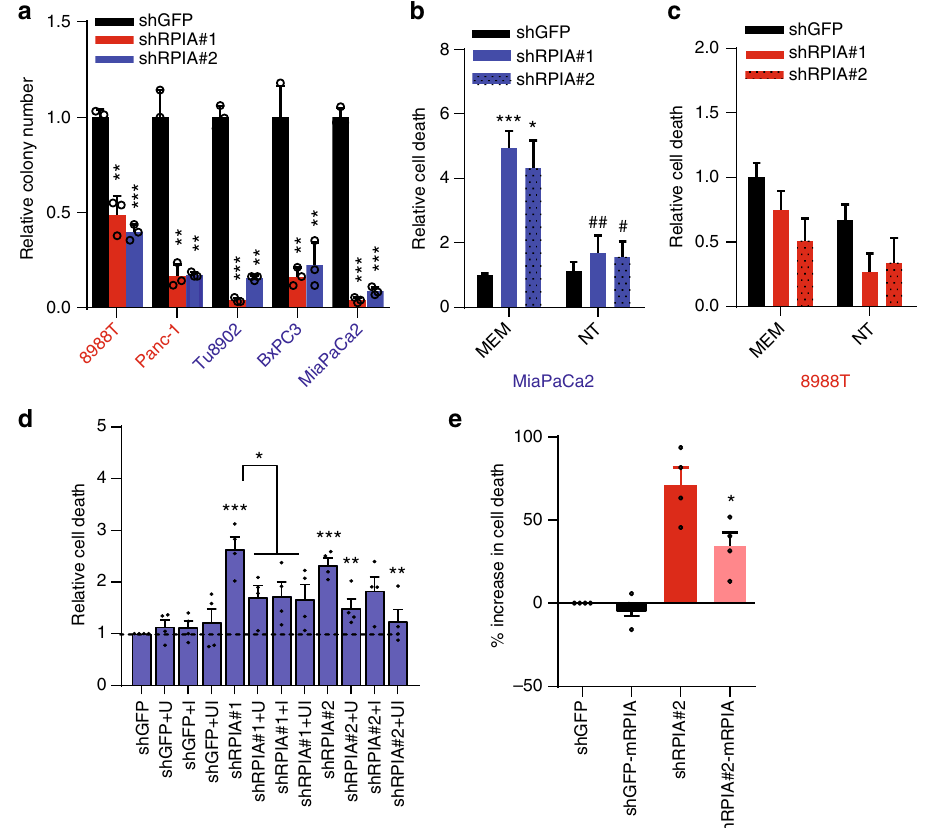
Fig. 5 RPIA and nucleotide biosynthesis are essential for PDAC cell survival. a RPIA was targeted using two different shRNAs. Clonogenic growth was assessed in several human PDAC cells compared to the control shGFP. Error bars ± s.d., triplicate wells of a representative experiment (8988T, MiaPaCa2 n = 4; Panc-1, BxPC3 n = 3; Tu8902 n = 2). b and c Cells depleted of RPIA were cultured in MEM or MEM containing nucleosides (10 mg/L or ≈ 0.04 mM, each) and cell death was assessed by trypan blue exclusion. Error bars represent s.e.m. of 3 independent experiments (* shows comparison to shGFP, # shows comparison to shRPIA in MEM). d Cell death analyzed by fl ow cytometry after RPIA depletion in MiaPaCa2 cells in media supplemented with U (uridine) and I (inosine) alone or in combination (1 mM, respectively). Bars represent relative fold change in cell death vs. shGFP of 4 averaged independent experiments (error bars show s.e.m). e Cell death analyzed by fl ow cytometry after RPIA depletion and mRPIA expression in MiaPaCa2 cells. Bars represent increase in cell death as compared to shGFP (error bars show s.e.m of 4 independent experiments). For all panels, signi fi cance determined with t- test . * p < 0.05, ** p < 0.01, *** p <